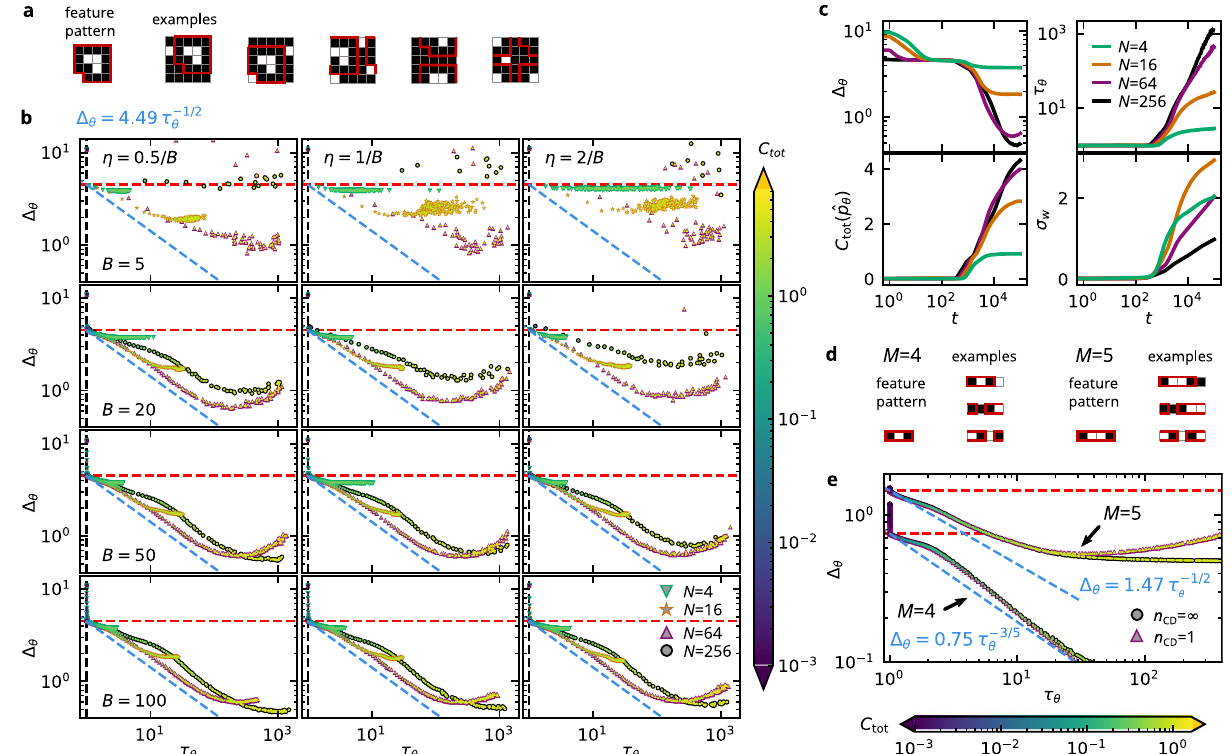
Fig.3|RBMlearningcharacteristicsforapatternrecognitiontask.a Thetarget forvarious N ; η =0.005, B = 100(cf. bottom left panelof b ). d Simpli fi ed model distribution consists of M =5×5 “ images ” subjectto periodic boundary conditions of M =1 ×4 or M = 1× 5 images with an implanted “ black-white(-white)-black ” and a fi xed 15-pixel “ hook ” pattern implanted at random locations, where the pattern. e Δ θ vs. τ θ for RBMs with N = 2 hidden units trained on the distribu- remaining pixels are active (white) with probability q =0.1. b Exact loss Δ θ vs. tions from d using the full target distribution (i.e., ∣ S ∣ = ∞ ) and exact autocorrelation time τ θ for RBMs with different numbers of hidden units N (see continuous-time gradient descent with either the full model distribution ^ p legend), trained on the distribution from a using contrastive divergence of order θ ð x , h Þ ( n CD = ∞ ) or contrastive divergence of order n CD =1. Data points are averages over 100 independent runs with different initial conditions. b , e Fill n CD =1with ∣ S ∣ =5000trainingsamplesandvariousvaluesofthebatchsize B (rows) andlearningrate η (columns).Datapointsareaveragesover fi veindependentruns. colors indicate the total correlation C tot ð ^ p θ Þ of the model distribution (see c Δ θ , τ θ , total correlation C tot ð ^ p θ Þ of the model distribution, and the standard colorbars), border colors and marker types indicate the number of hidden P 2 Þ 1 = 2 asafunctionofthe trainingepoch t units N (see legends in bottom-right deviationofthe weights σ w : = ð 1 i , j w ij MN (cid:2) 1